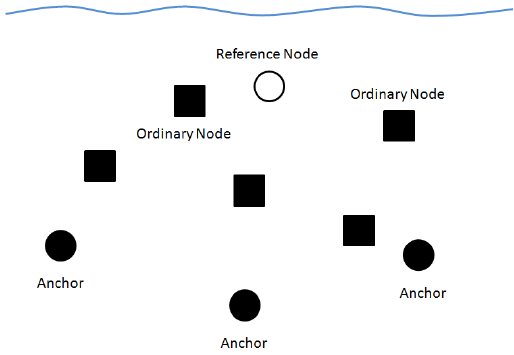
Figure 1. The network architecture.